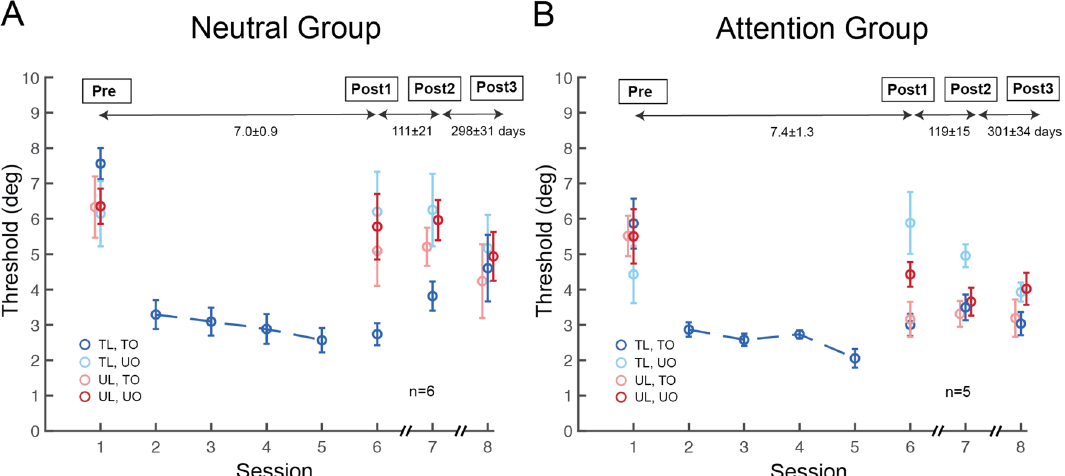
Figure 5. Session-by-session thresholds of Pre-test, Post-test 1, Post-test 2, and Post-test 3 in the Neutral and Attention groups. 6 observers from the Neutral group and 5 observers from the Attention group were re-tested 1 year after the completion of training. Similar to results in Post-tests 1 and 2, the perceptual improvement in both groups and location transfer in the Attention group were preserved. Error bars represent ± 1 within-subject